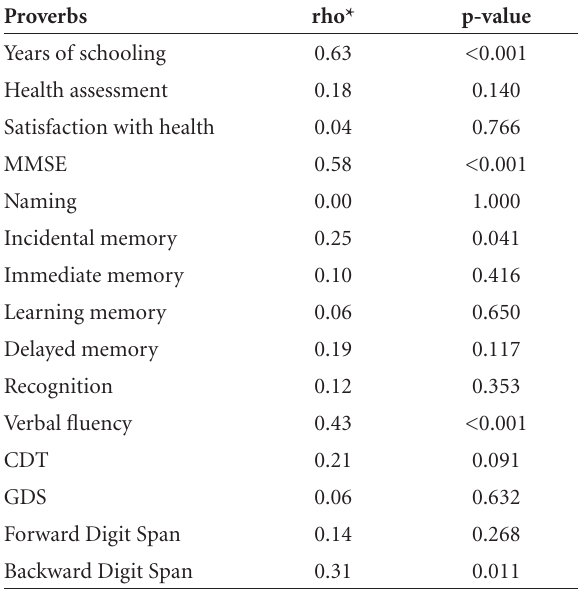
Table 3. Spearman’s Correlations between Proverbs Test and in- dependent